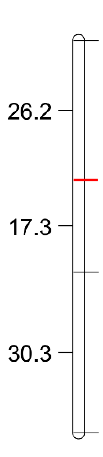
Figure 5. Genetic linkage map showing the position of Rht18 on chromosome 6A . Genetic distances are shown in centiMorgans (cM).